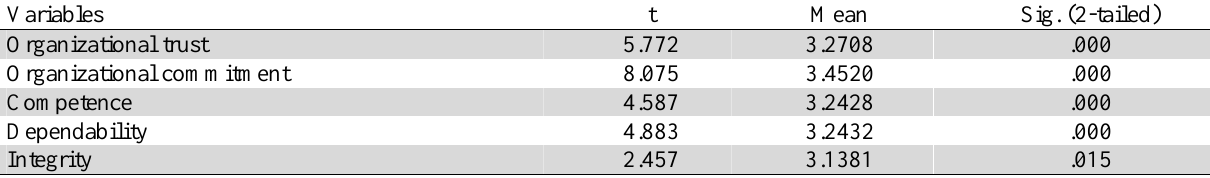
One-Sample Test on Organizational trust